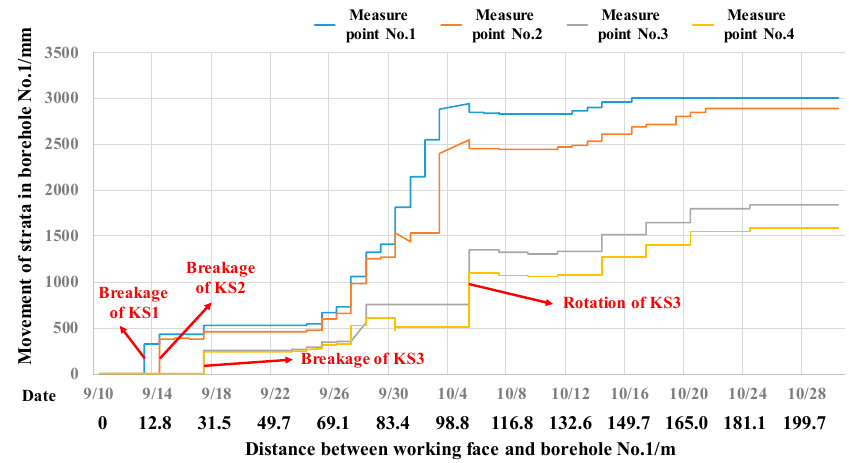
Figure 3. Variation of strata movement in borehole No. 1 with advancement of the working face.